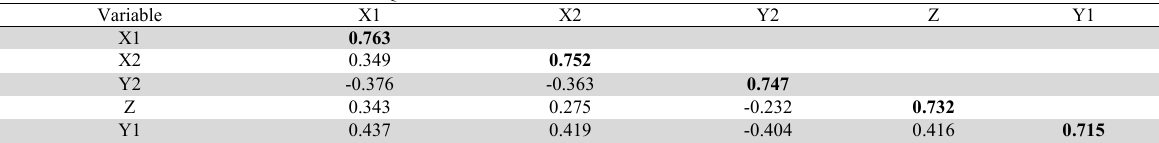
Correlation between Construct and AVE Quadrate Root